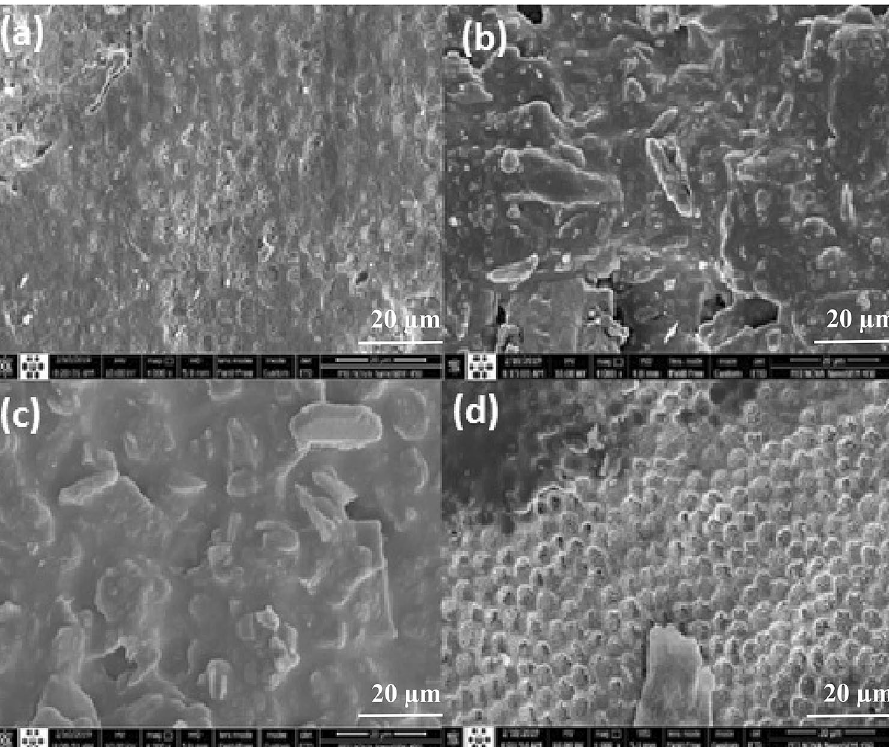
Figure 4. SEM images related to enamel surface treatment with (a) C + FV, (b) Air-DBD + FV, (c) ArJ + FV, (d) He-DBDJ + FV.